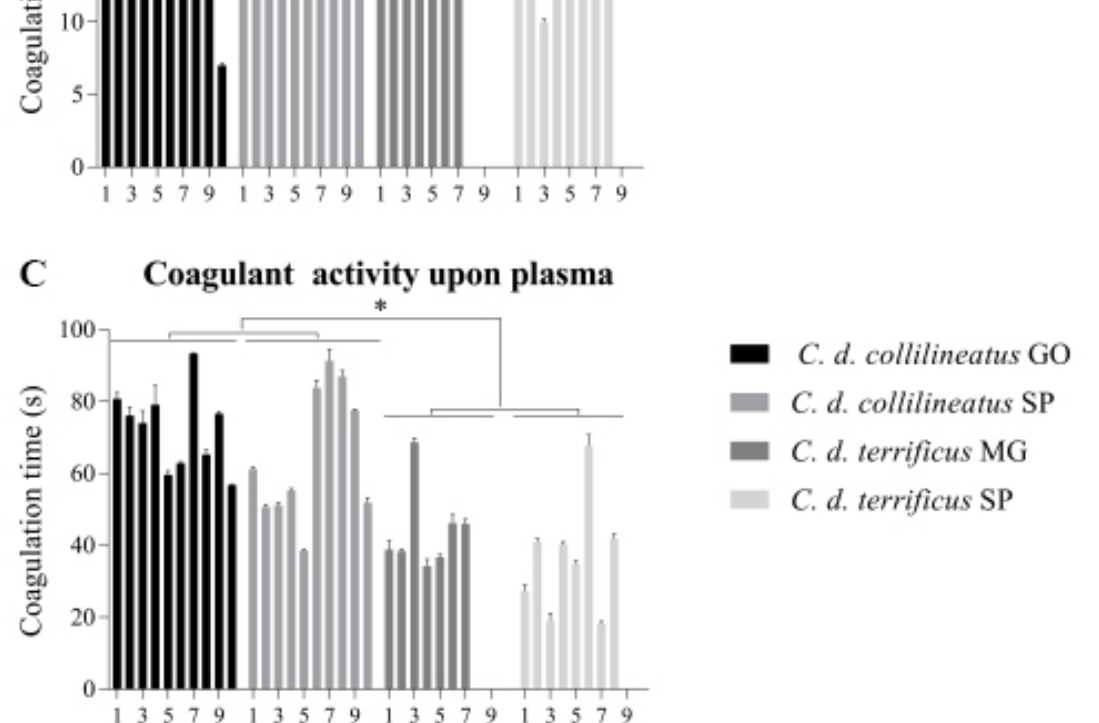
Figure 9. Coagulant activity of individual C. d. collilineatus and C. d. terrificus venom. ( A ) Thrombin-like activity upon the chromogenic substrate S-2238 (Chromogenix), ( B ) thrombin-like activity upon bovine fibrinogen, and ( C ) coagulant activity upon human plasma. Results were expressed as mean ± SDM. C. d. collilineatus GO: specimens from Goiás state; C. d. collilineatus SP: specimens from São Paulo state; C. d. terrificus MG: specimens from Minas Gerais state; C. d. terrificus SP: specimens from São Paulo state; *p <